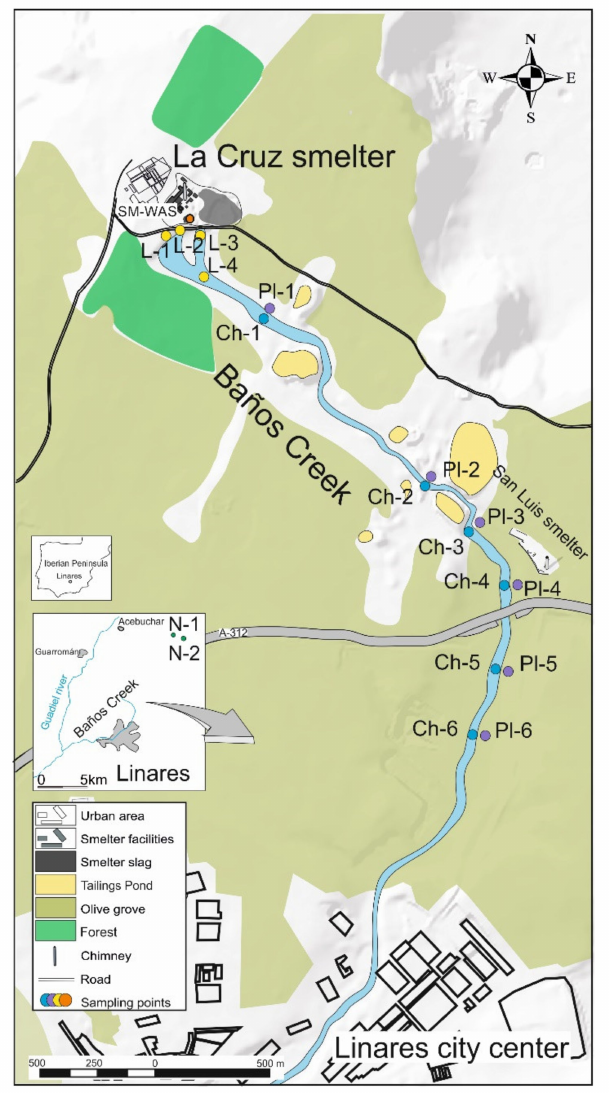
Figure 1. Study area and location of the sampling points: SM-WAS, metallurgical waste; L, leachate discharge area; Ch, creek bed sediments; Pl, floodplain